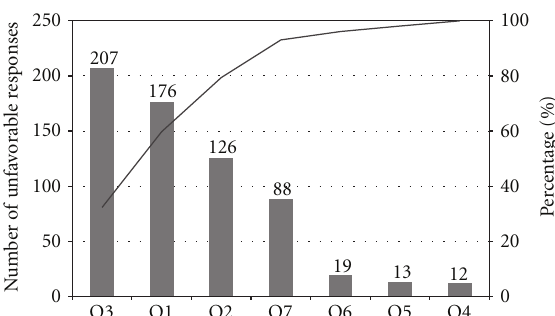
Figure 2: Pareto chart showing the contribution of each of the questions to unfavorable responses. The bars represent the number of unfavorable responses for each of the questions Q1 to Q7 (total number of unfavorable responses = 641). The black line represents the accumulated percentage.